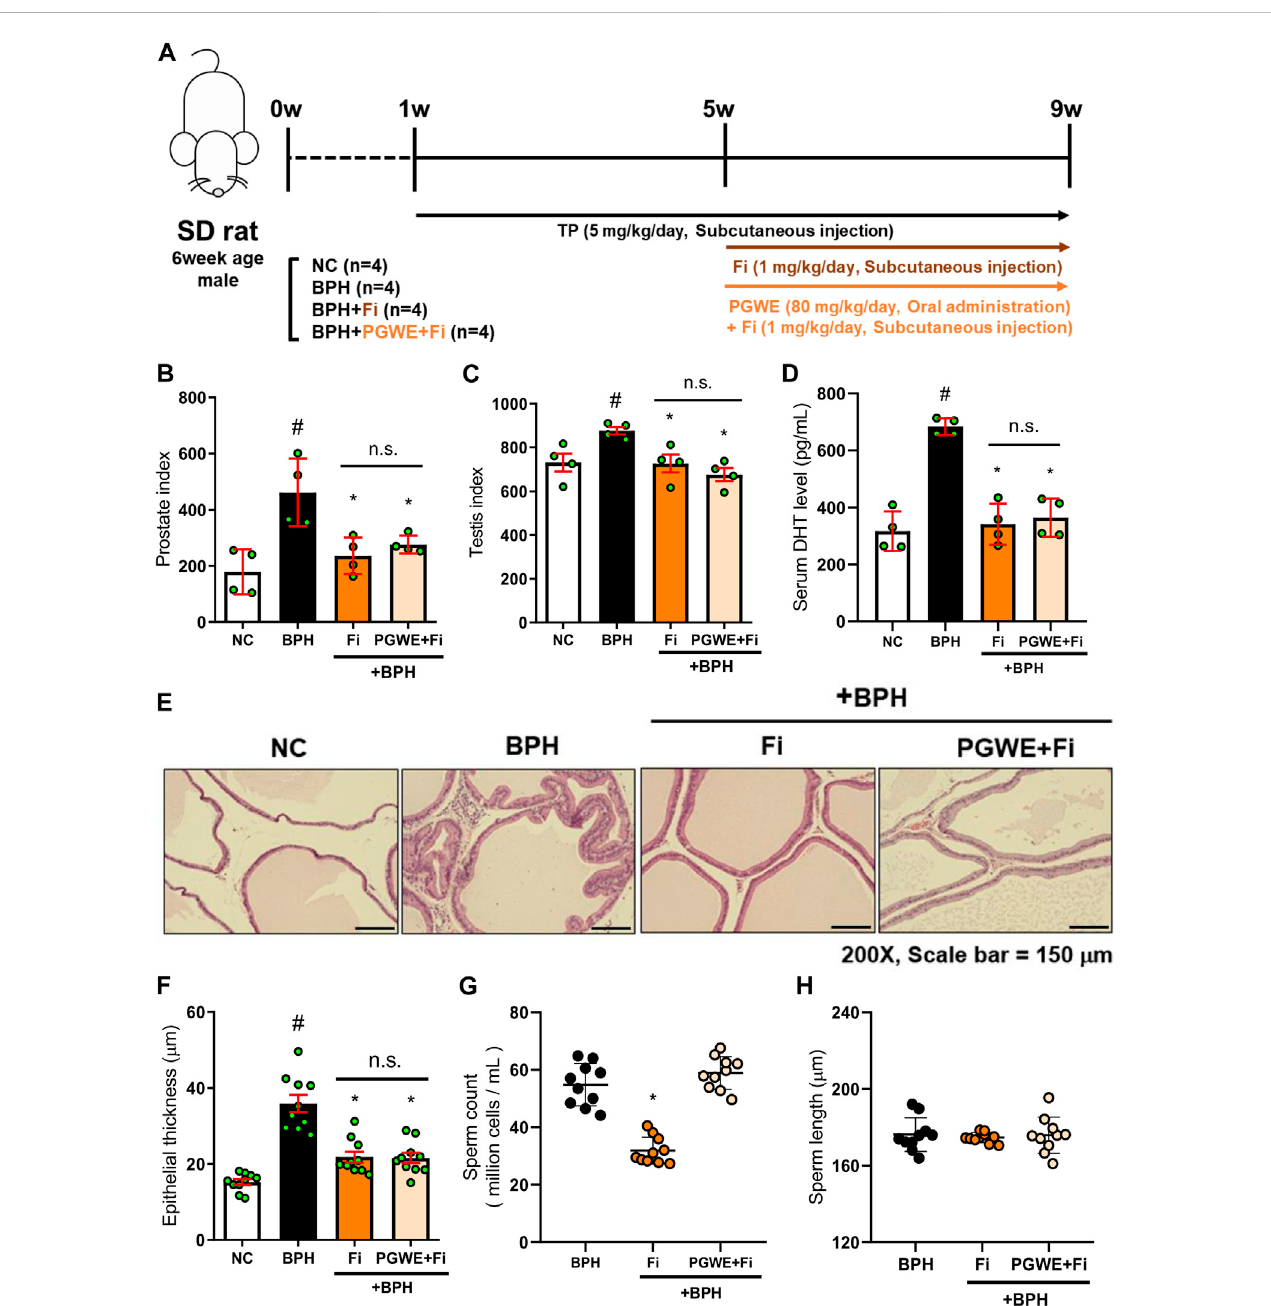
FIGURE 6 PGWE restores loss of sperm count by Fi (A) Experimental scheme of in vivo study (B) The prostate index was calculated by prostate weight (mg)/body weight (100 g) (C) The testis index was calculated by testis weight (mg)/body weight (100 g) (D) Serum DHT levels were analyzed using ELISA kits (E) H and E staininganalysiswasperformedusingprostatetissuesofTP-inducedBPHrats(magni fi cation×200,scalebar150 µm) (F) BasedonH&Estaining,theepithelial thickness was measured using ImageJ software (G) Number of sperm extracted from the epididymis of rats and (H) length of sperm were calculated using ImageJ software. All data are expressed as mean ± SEM of independent experiments. Statistical differences were calculated by one-way ANOVA with post-hoc Tukey ’ s test. # p < 0.05 vs. NC group; p p < 0.05 vs. BPH group. TP, testosterone propionate; NC, normal control; BPH, benign prostatic